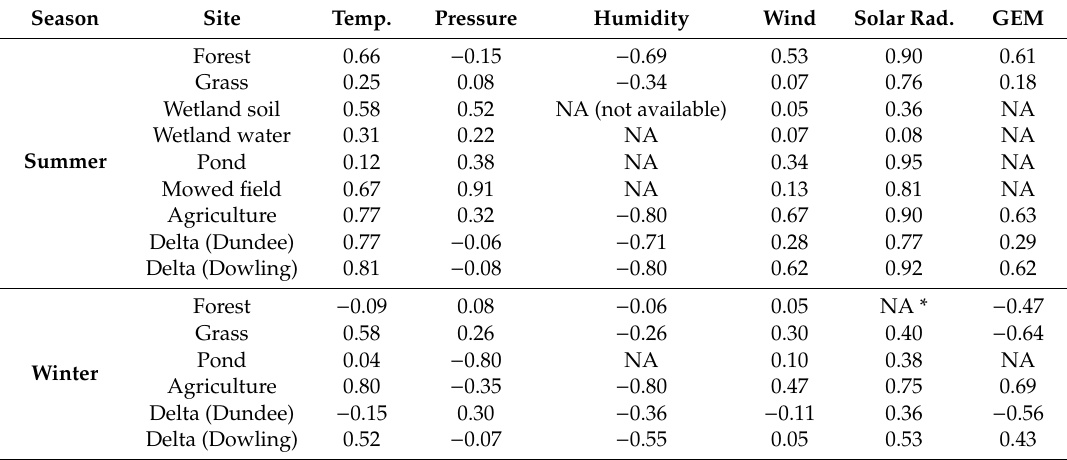
Table 2. Pearson correlations for gaseous elemental mercury (GEM) fluxes with meteorological parameters and ambient GEM concentrations. Numbers that are italic and red have p values <